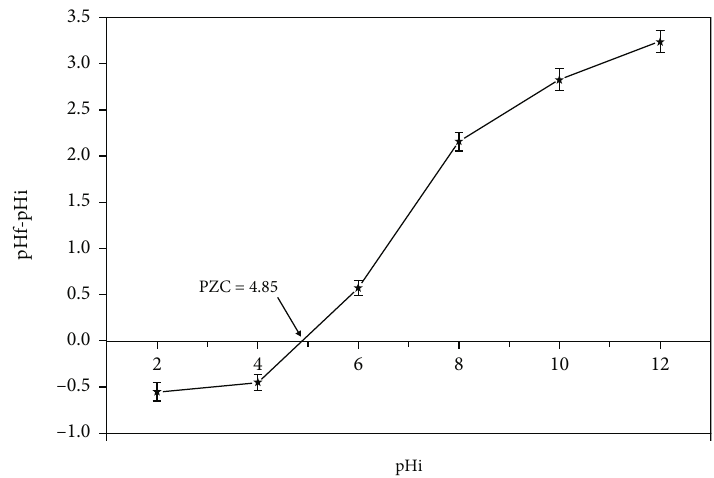
Figure 3: PZC analysis for chemically modi fi ed neem biomass